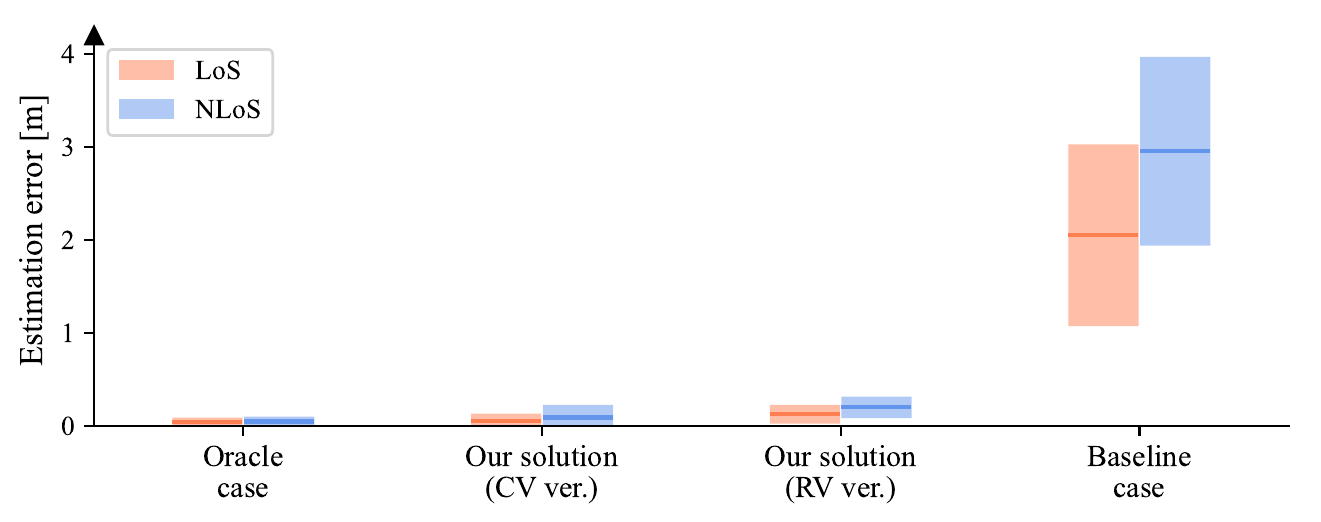
C = 144, A = 51.84, σ = 0 . Given the squared error { }